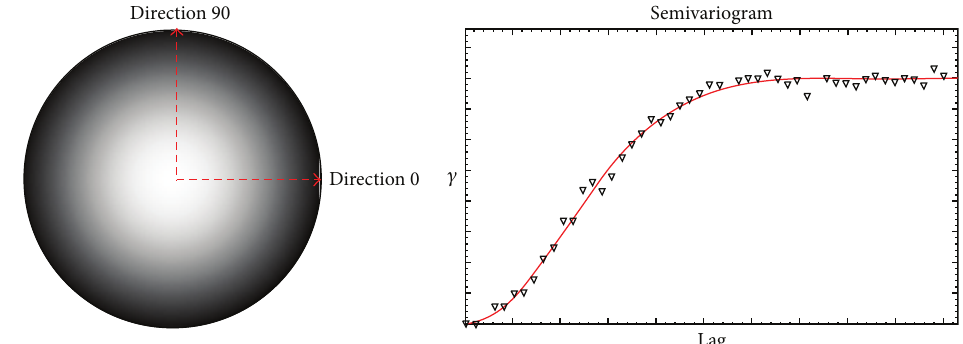
Figure 4: Example of isotropic distribution phenomenon.